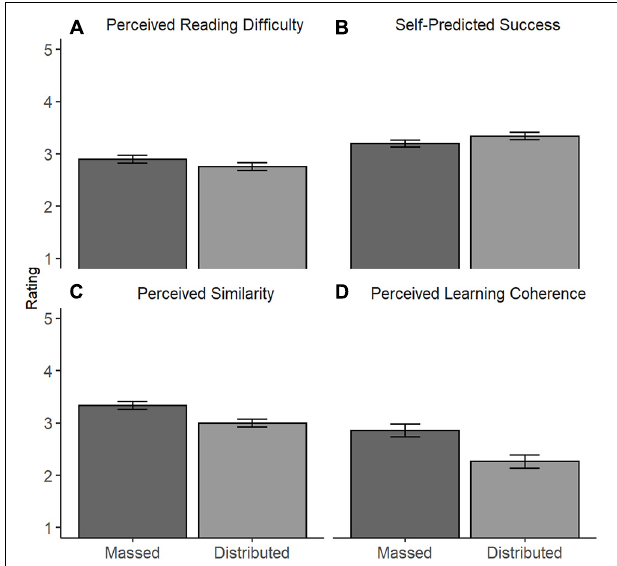
FIGURE 3 | Main Effect of Learning Condition on Meta-Cognitive Judgments of Learning in Experiment 1. Estimated means of (A) perceived difficulty (recoded, 1: very easy; 5: very difficult), (B) predicted success (recoded, 1 = very good; 5 = very bad), (C) perceived similarity, and (D) perceived learning coherence (1 = not true; 5 = true) for the learning conditions, Experiment 1. Error bars represent standard errors (-/ + 1